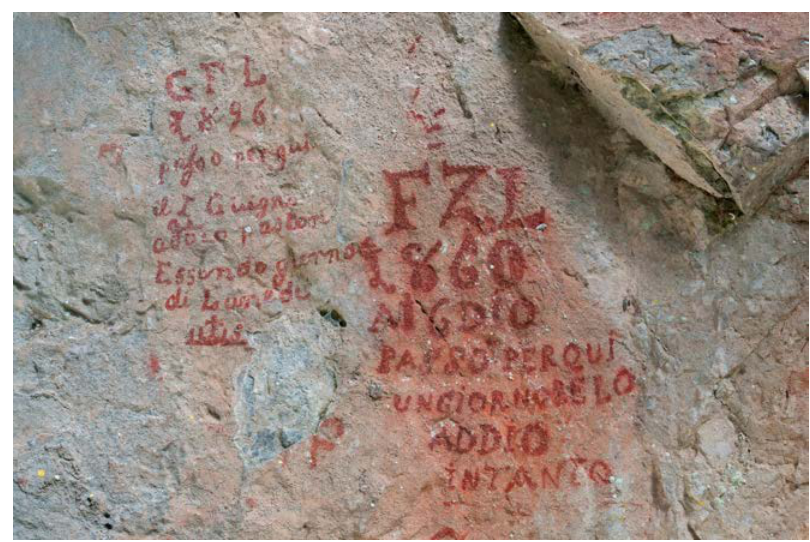
Figure 7 – Fiemme Valley, Mount Cornón: example of writing of the second period. Courtesy of Museo degli Usi e Costumi della Gente Trentina